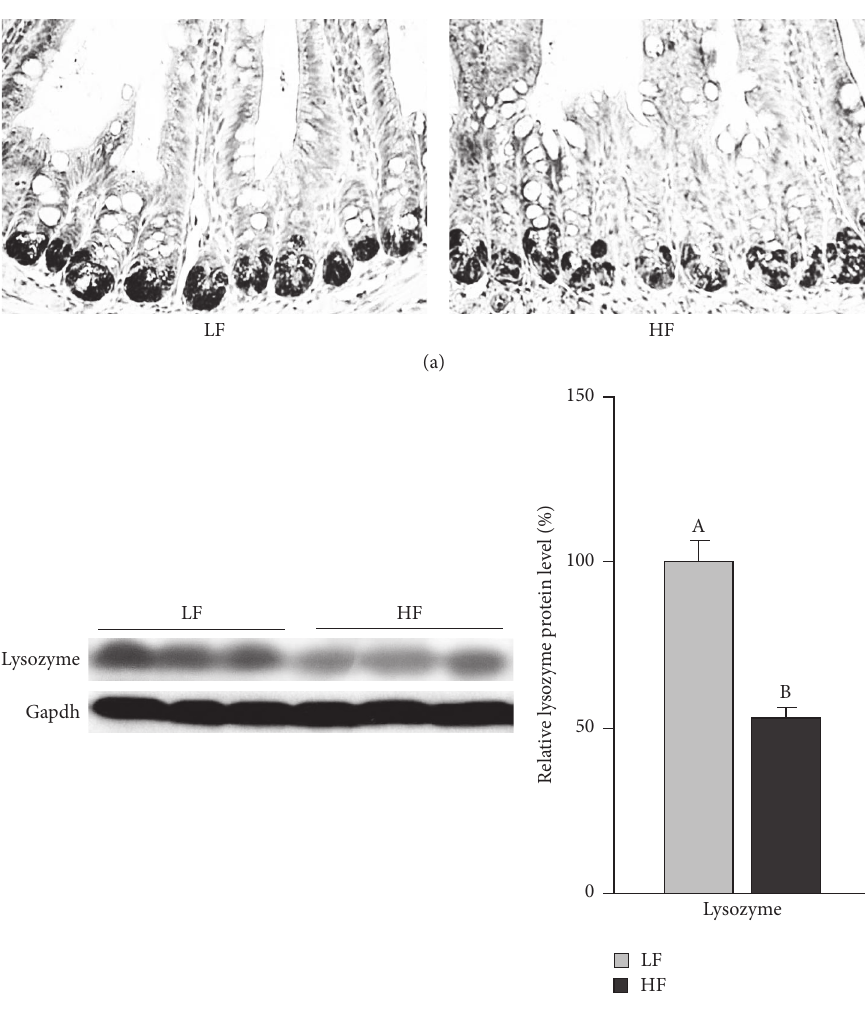
Figure 4: Effect of high fat diet consumption for 16 weeks on the protein levels of lysozyme in the small intestinal epithelial cells. (a) Immunohistochemistry; (b) western blotting.